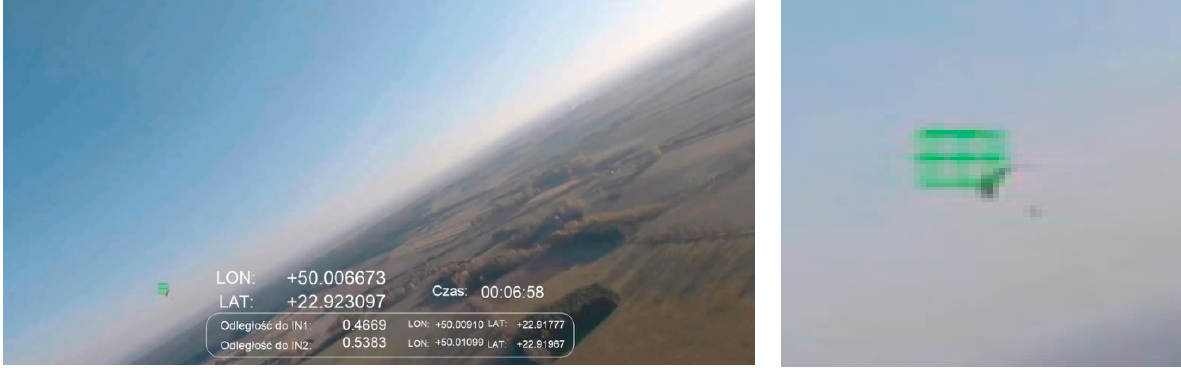
Figure 14. Qualitative analysis of the detection of an intruder with LDO = 10 m (results for image processing on board a flying plane, real time computations). The intruder detection algorithm was also tested in situations of the simultaneous appearance of multiple objects (intentional tests or accidental situations). In Figure 15A, we can see both the paraglider at a distance of about 1 km, but also an airliner flying at cruising altitude, which accidentally appeared in the field of view of the camera. The in- tended test of the possibility of simultaneous detection of two paragliders is presented in Figure 15B. The paragliders were detected at distances of approx. 300 m and 800 m. In both of these cases, the flight took place at an altitude of about 150 m above farmland and under a cloudless sky. Under such conditions, the algorithm worked properly.